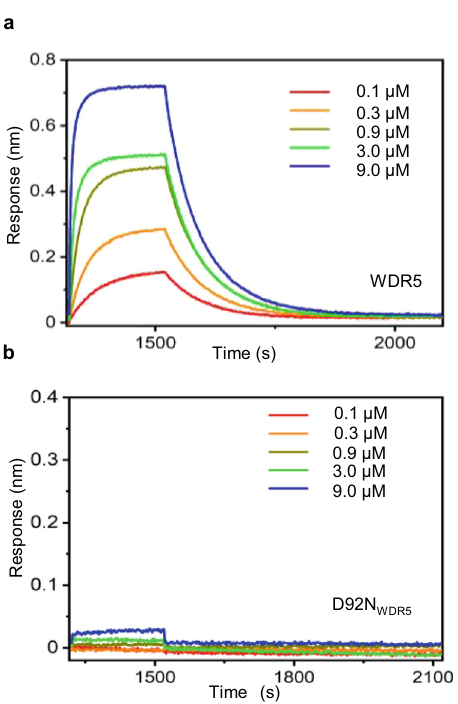
Fig. 3 Biolayer interferometry (BLI) sensorgrams of MLL4 Win -WDR5 interactions. a 5 nM biotin-tagged MLL4 Win peptide was loaded onto streptavidin sensors for 5 min. Individual binding curves are indicated for [WDR5] from 0.1 µ M to 9 µ M. b The same BLI measurements as described in ( a ), but conducted with D92N WDR5 . Source data are provided as a Source Data fi